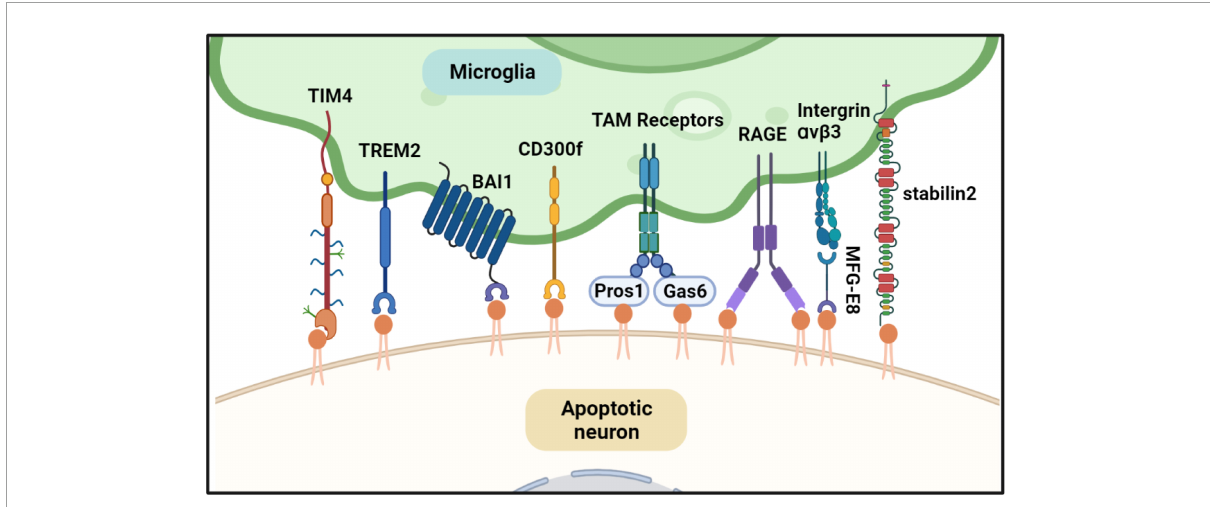
FIGURE4 Phosphatidylserine (PS) is involved in microglia-mediated neuron apoptosis. When the neuron is undergoing apoptosis, PS is exposed to the cell surface. Microglia can find and phagocyte the apoptotic neuron. Several PS effectors expressed in microglia can recognize the exposed PS directly or indirectly. TREM2, RAGE, TIM4, and BAI1 can bind PS directly. TAM receptors recognize PS indirectly through their ligands Gas6 and ProS1. Both Gas6 and ProS1 have Gla-domain to bind PS. As well as TAM receptor, intergrin α v β 3 recognize PS through MFG-E8. All of the PS effectors can trigger cytoskeletal rearrangement of microglia and engulf the dying neuron. Created with